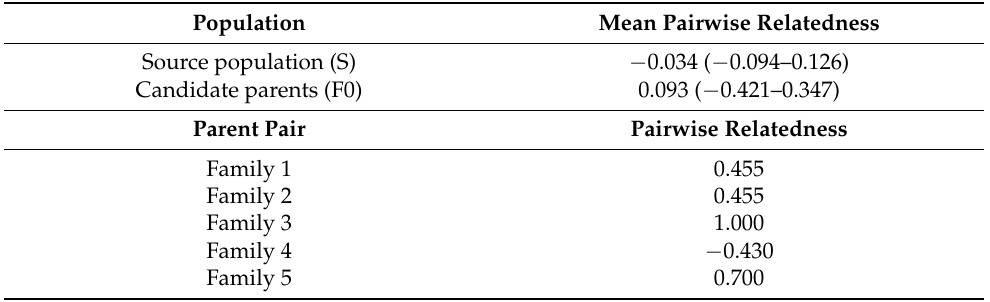
Figure 4. Inbreeding coefficients ( F IS ), unbiased expected heterozygosity (u H E ) and observed heterozygosity ( H O ) for three Hermetia illucens cohorts: the source population (S), parent pairs (F0) and offspring (F1). Error bars indicate standard error. Table 4. Mean pairwise relatedness of a Hermetia illucens population (S) and a group of candidate parents from the population (F0), as well as pairwise relatedness estimates for each of the five individual parent pairs. Standard errors for the two sample groups are indicated in